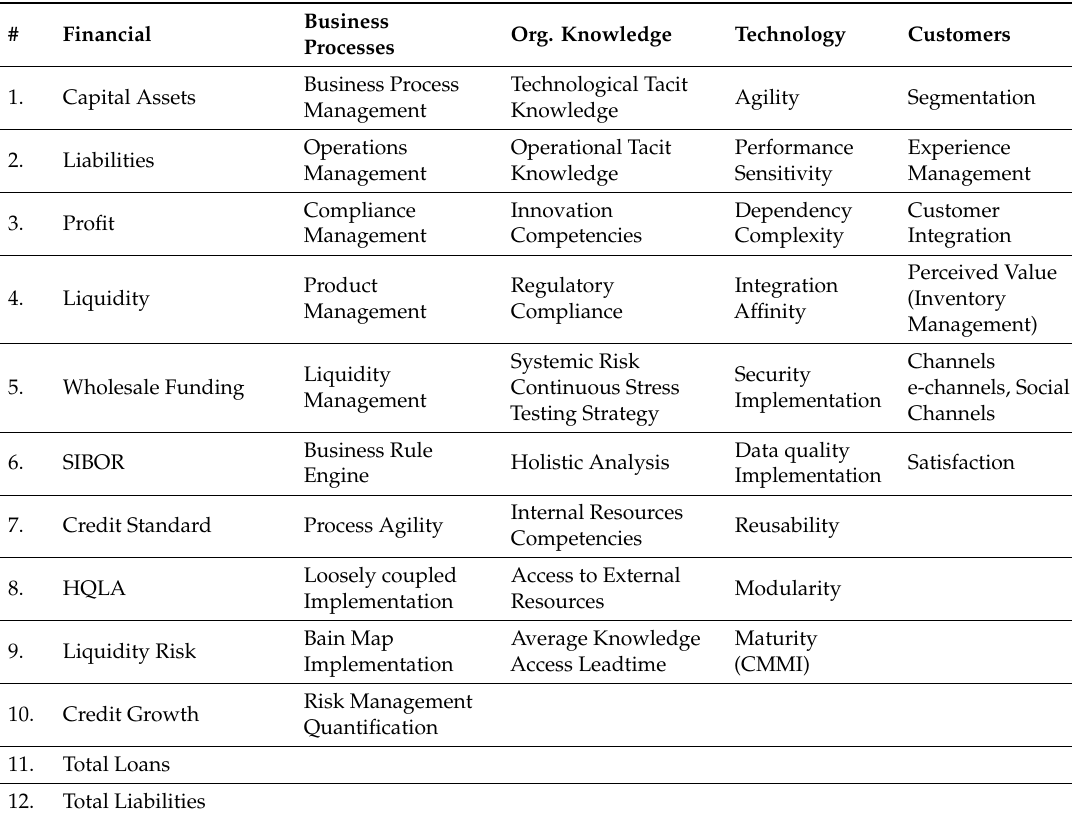
Table A2. Quality Attribute Constraints parameters.